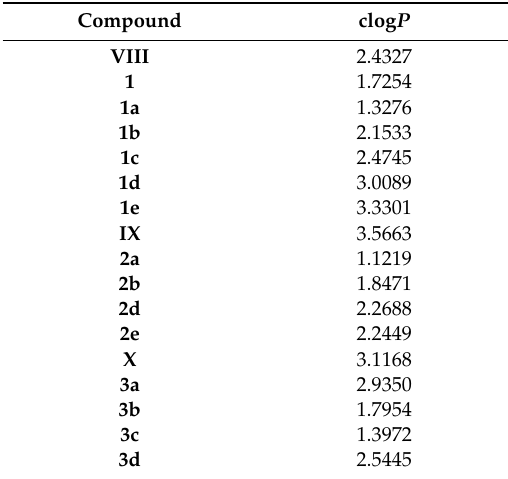
Table 1. Theoretical log P values (clog P ) for obtained compounds calculated by the OSIRIS Property Explorer